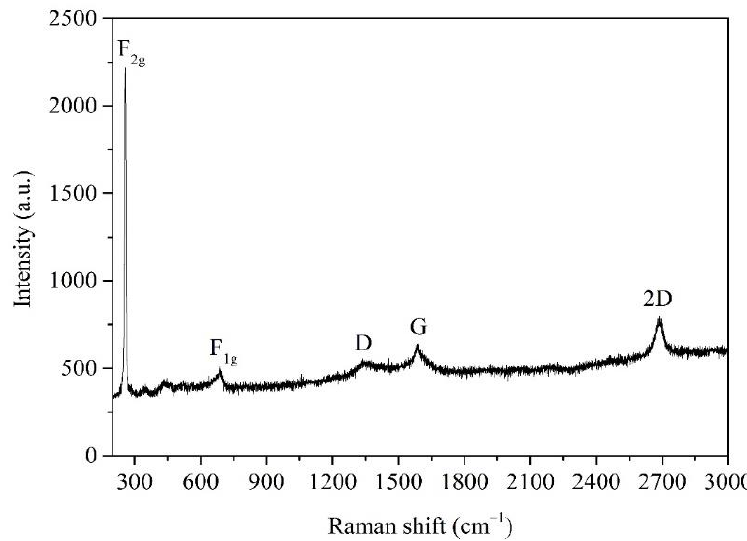
Figure 3. The Raman spectrum of MLG/Mg 2 Si/Si heterojunction.